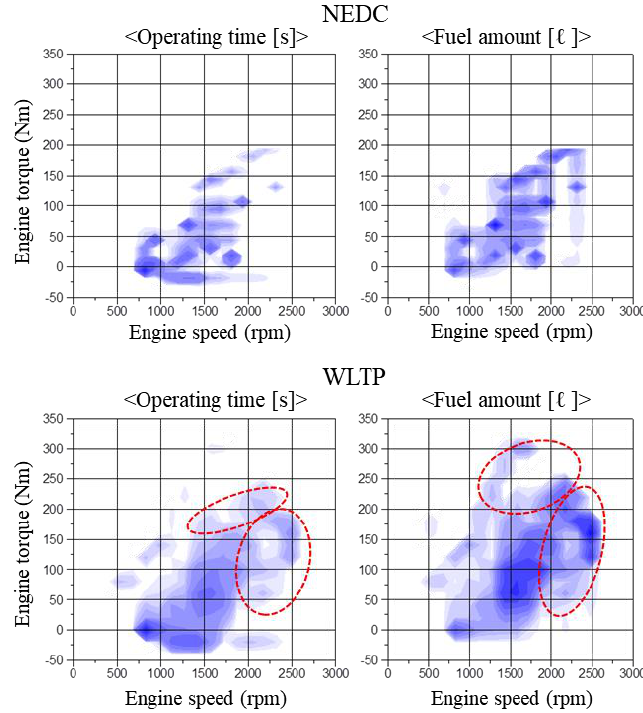
Figure 12. Operation time and fuel amount according to the driving cycle of the diesel vehicle.